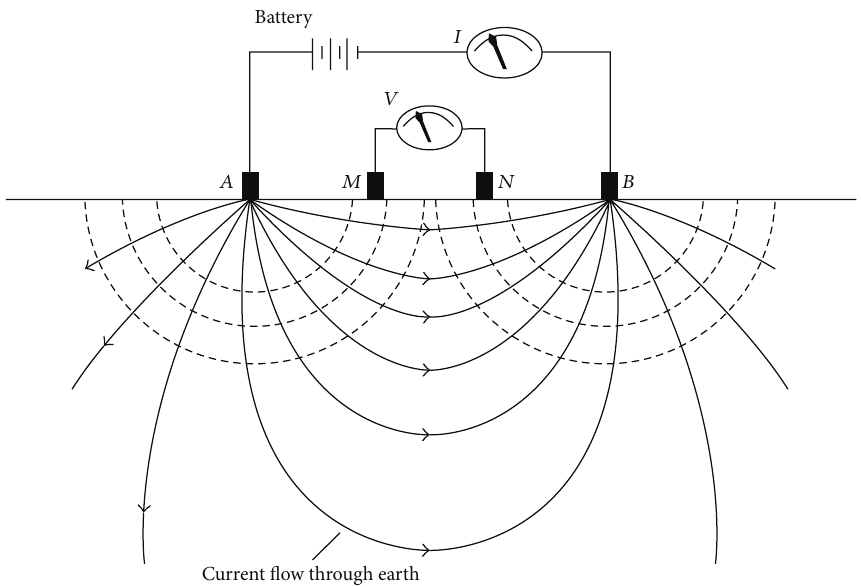
Figure 1: Schlumberger electrode